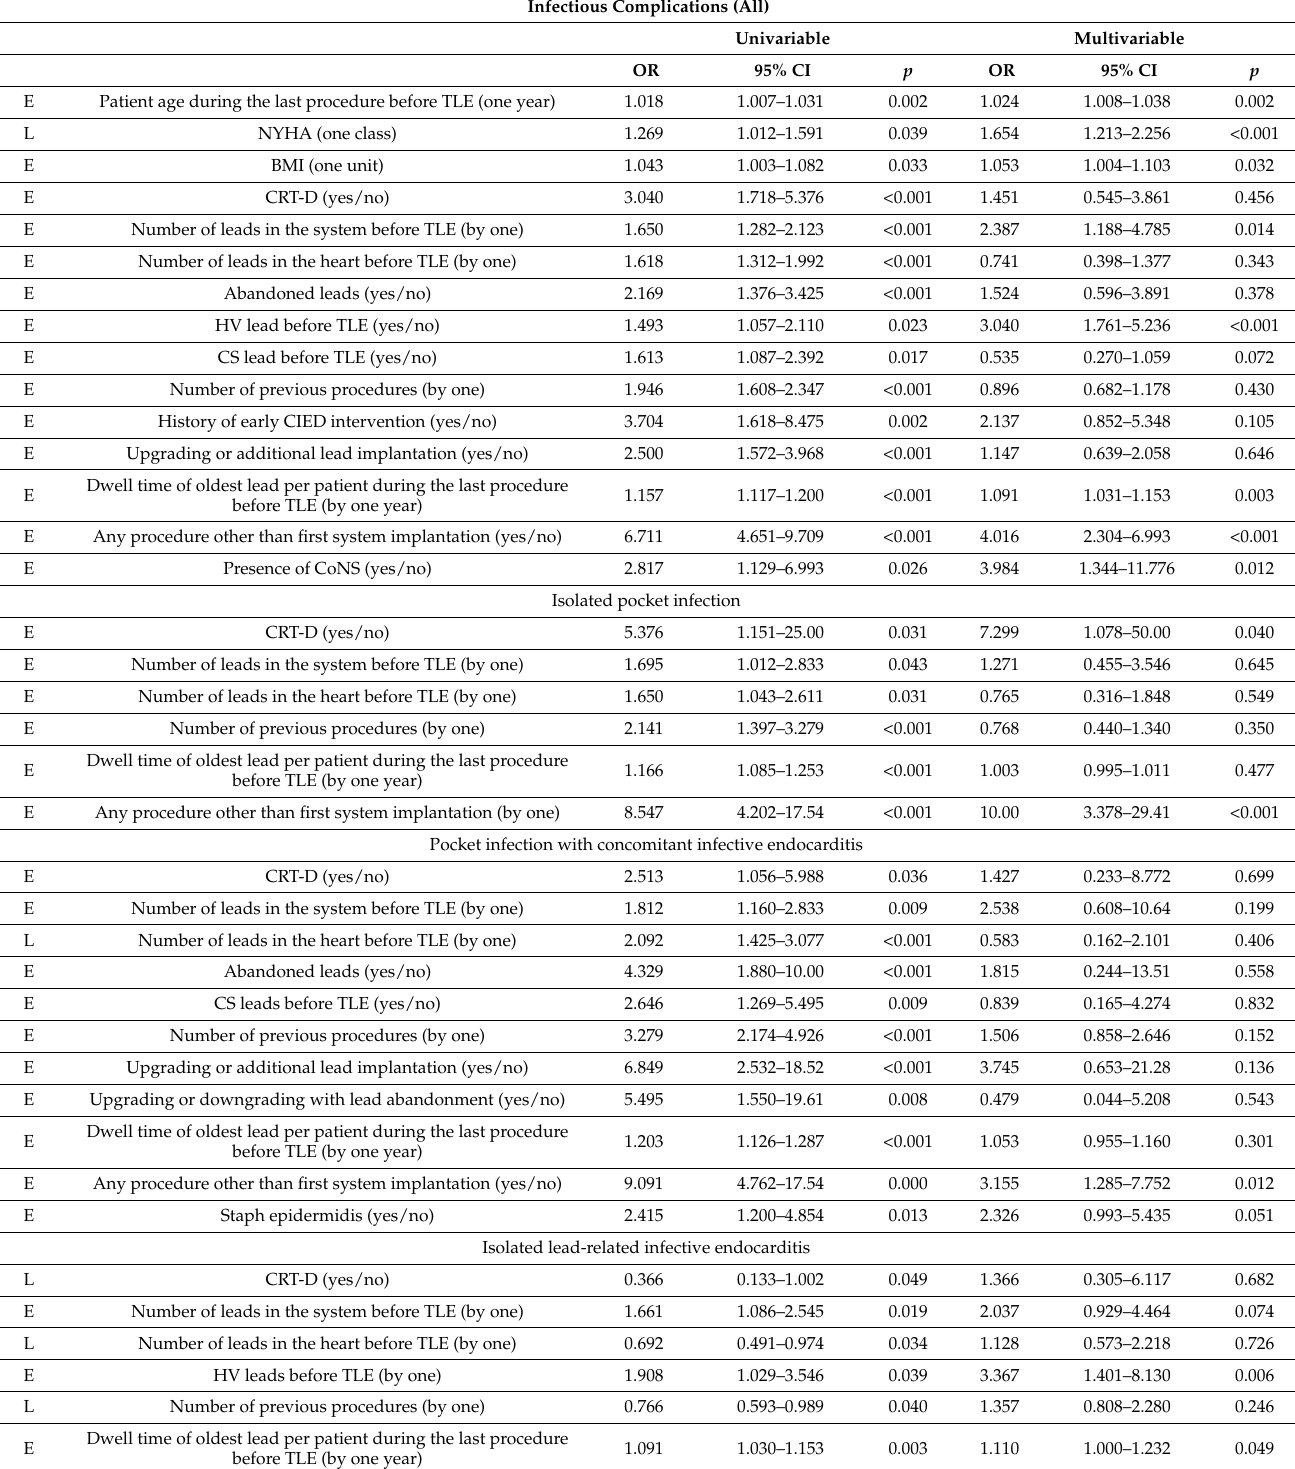
Table 5. Clinical, procedural, bacteriological and CIED-related factors affecting onset (<12 months or >36 months) of infections after revision procedure. The results of univariable and multivariable linear regression